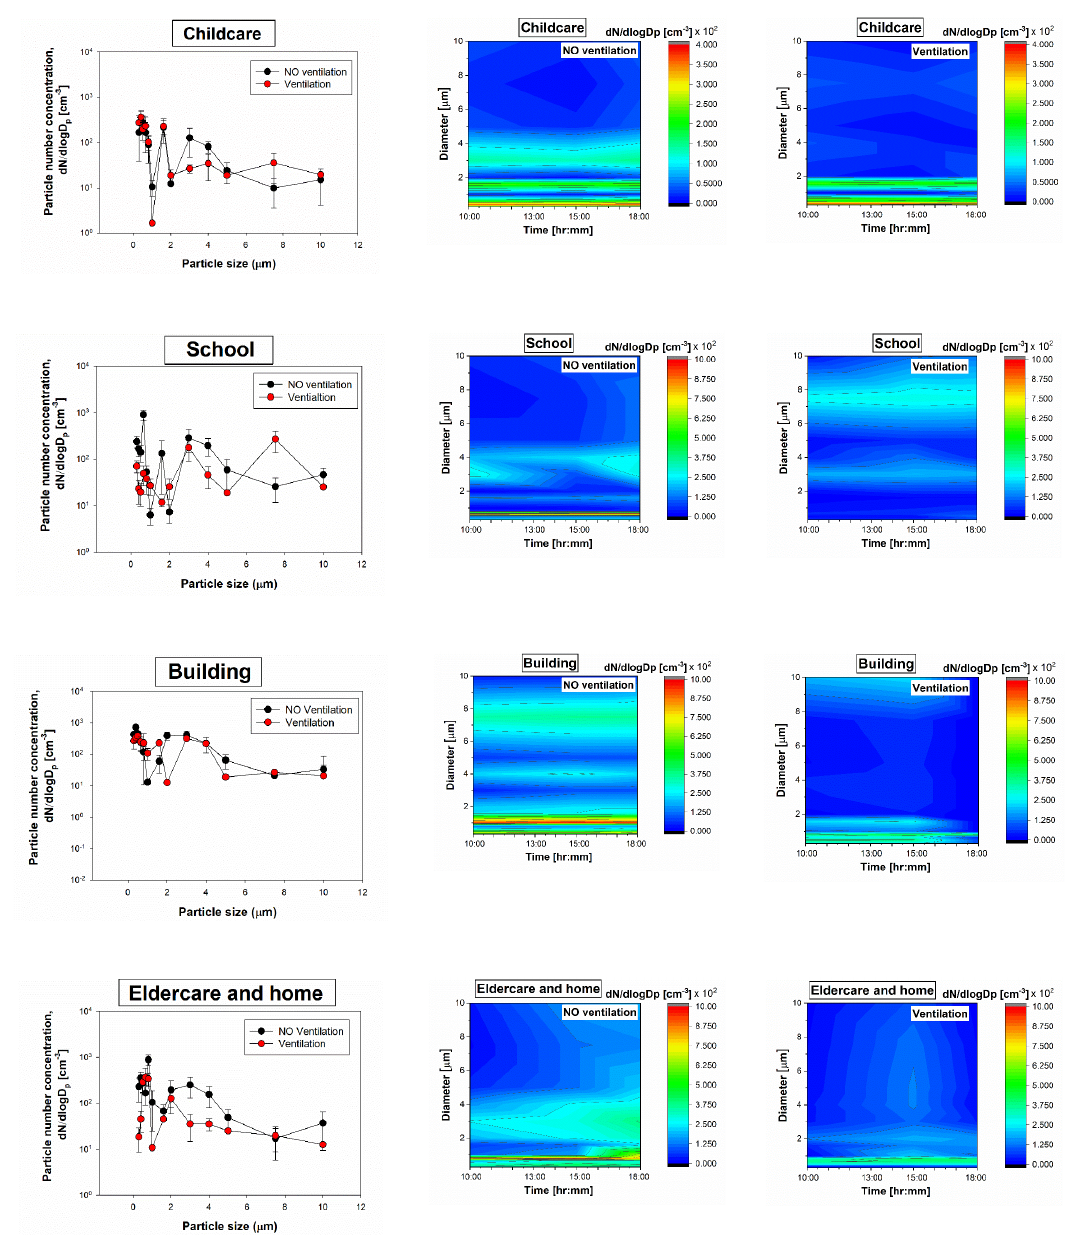
Figure 4. Size distributions of indoor particles in di ff erent places (childcare, school, commercial building, elderly facility and homes) and their variation with time as a function of ventilation. The data present averages of three